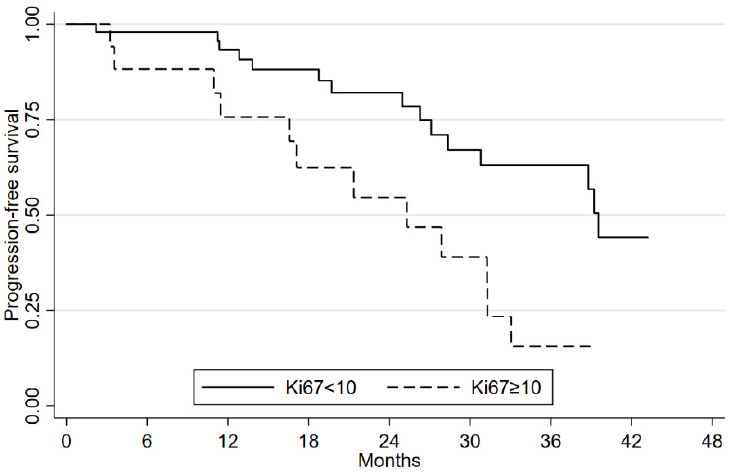
Figure 1. Progression-free survival according to Ki67 values. Patients who underwent previous primary tumor surgery showed a benefit in terms of both mPFS and mOS, with a mPFS of 39.2 months (95%CI 28.3–54.1) compared to